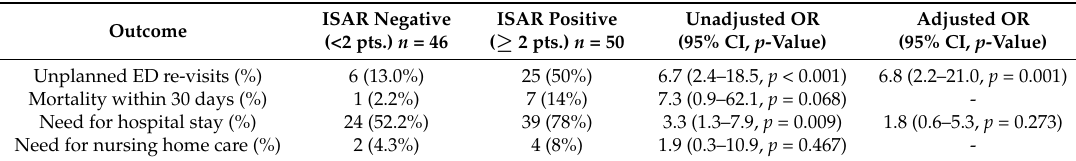
Table 2. Outcome Analysis if ISAR (<2/ ≥